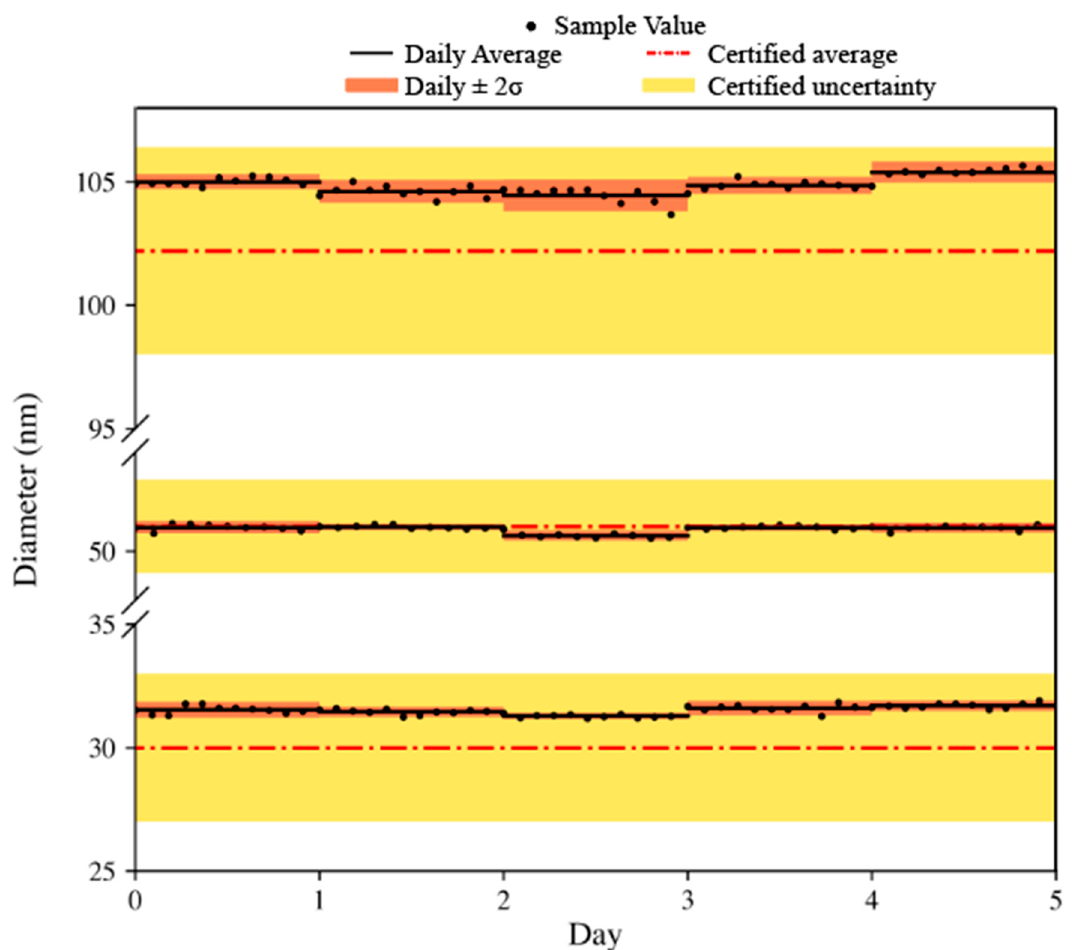
Figure 4. Determination of the Au diameter by SP-ICP-TOF-MS presented for the 50 nm Au, 100 nm Au, and 60 nm Au/Ag NPs presented with the individual sample measurements for each day over the course of 5 days. Each day is presented with its average value (black line) and standard deviation at 2 σ (orange shaded box). All data are compared to the certified value (orange dashed line) with its respective standard deviation (yellow shaded box).